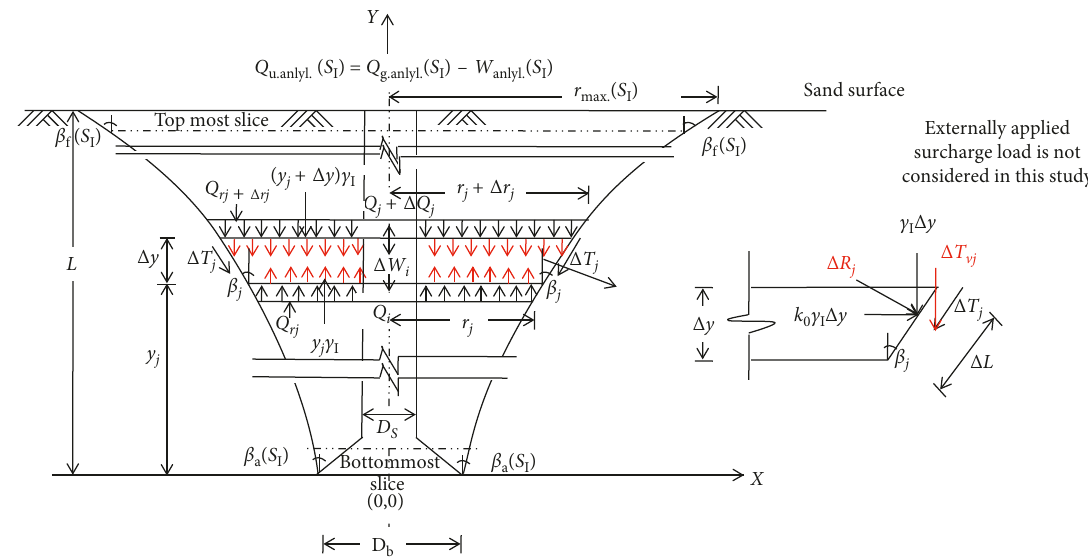
Figure 14: Free body diagram of a three-dimensional elemental slice wedge as per the horizontal slice method, in homogeneous sand deposit ( S I ).